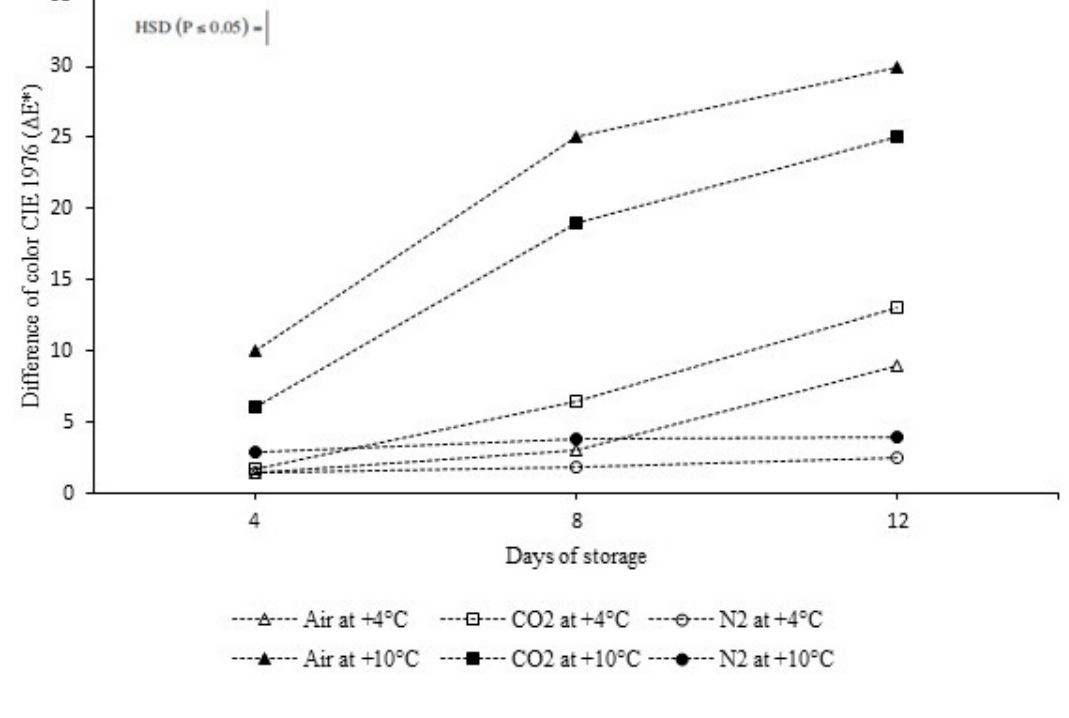
Figure 3. Color difference ( Δ E*) CIE 1976 over 12 days of storage at +4 °C and +10 °C in air, 100 ± 1 kPa of CO 2 , and 100 ± 1 kPa of N 2 , respectively. The value “five” in the ordinate indicates the limit beyond which the human eye perceives strong color differences.